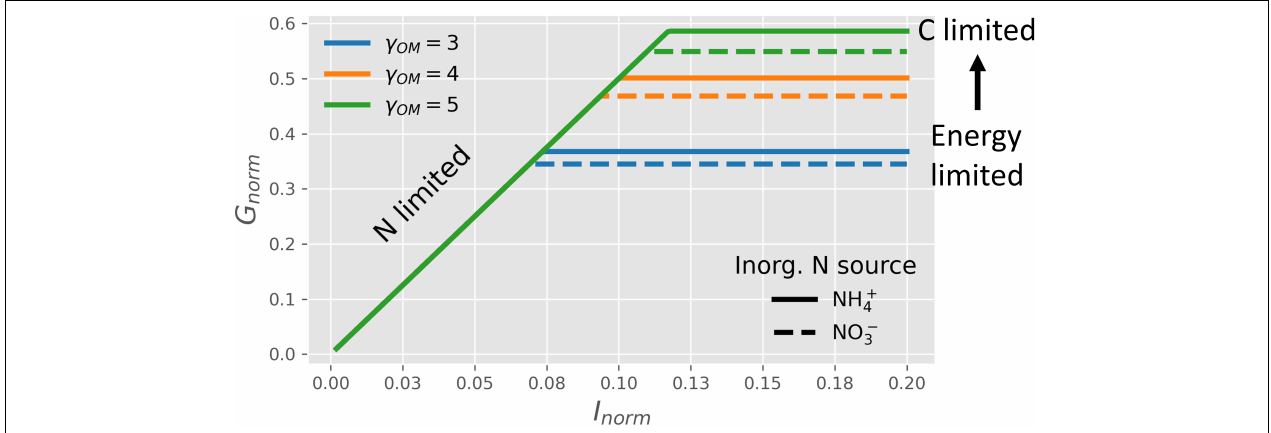
FIGURE 4 | OM without N: normalized microbial growth rate ( G norm ) under oxic conditions as a function of N Inorg -availability ( I norm ), degrees of reduction of the OM ( γ OM ; lines with different colors), and source of N Inorg (solid lines for NH + 4 vs. dashed lines for NO − 3 ). Horizontal lines, blue to green, represent the transition from energy to C-limited conditions.